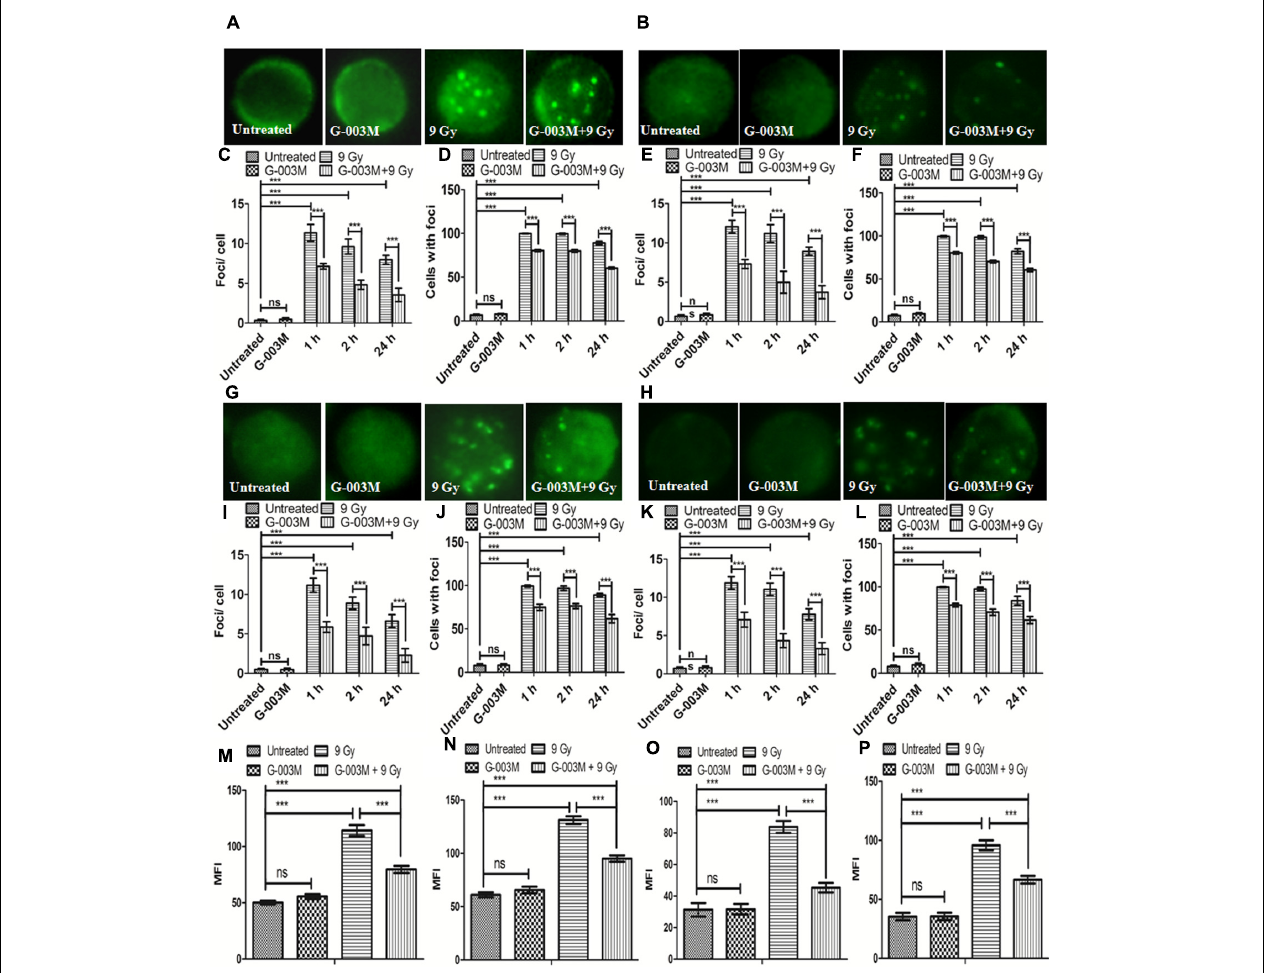
FIGURE 4 | Analysis of γ H2AX and p53BP1 foci in blood and bone marrow populations at various times after exposure of mice to ionizing radiation: (A,B) Represent assessment of γ H2AX foci in the blood and bone marrow respectively. (C) Average γ H2AX foci per cell (D) γ H2AX foci distribution in blood cells. (E) Average γ H2AX foci/ cell (F) γ H2AX foci distribution in bone marrow cells. (G,H) p53BP1 foci induction in the blood and bone marrow samples respectively. (I) Average p53BP1 foci per cell in blood (J) p53BP1 foci distribution in blood cells. (K) Graphs showing the mean p53BP1 foci per cell in bone marrow cells and (L) foci distribution in bone marrow cells. (M) Graph representing the mean fluorescence intensity of γ H2AX in blood cells. (N) Graph showing the mean fluorescence intensity of γ H2AX in bone marrow cells. (O) Graph representing the mean fluorescence intensity of p53BP1 in blood cells. (P) Graph showing the mean fluorescence intensity of p53BP1 in bone marrow cells. n = 6 per